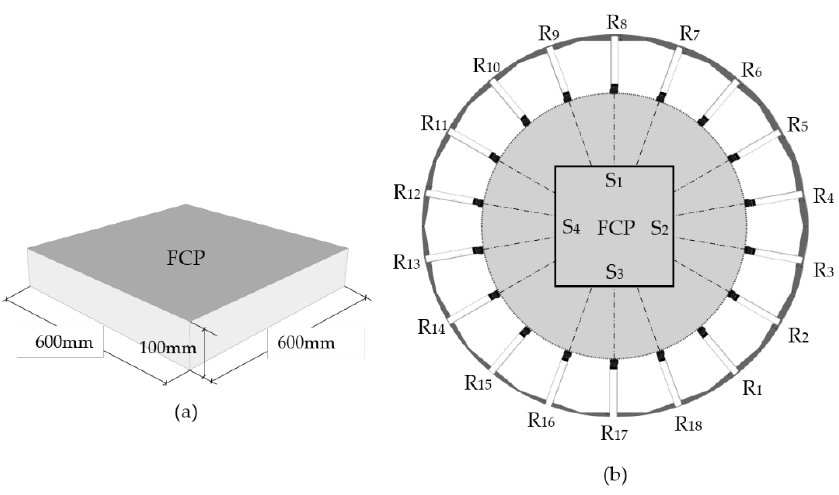
Figure 14. Design for FCP production: ( a ) Designed shape; ( b ) Operating rod. Table 1. Operating distance of the rod that implements the FCP shape (unit: mm).